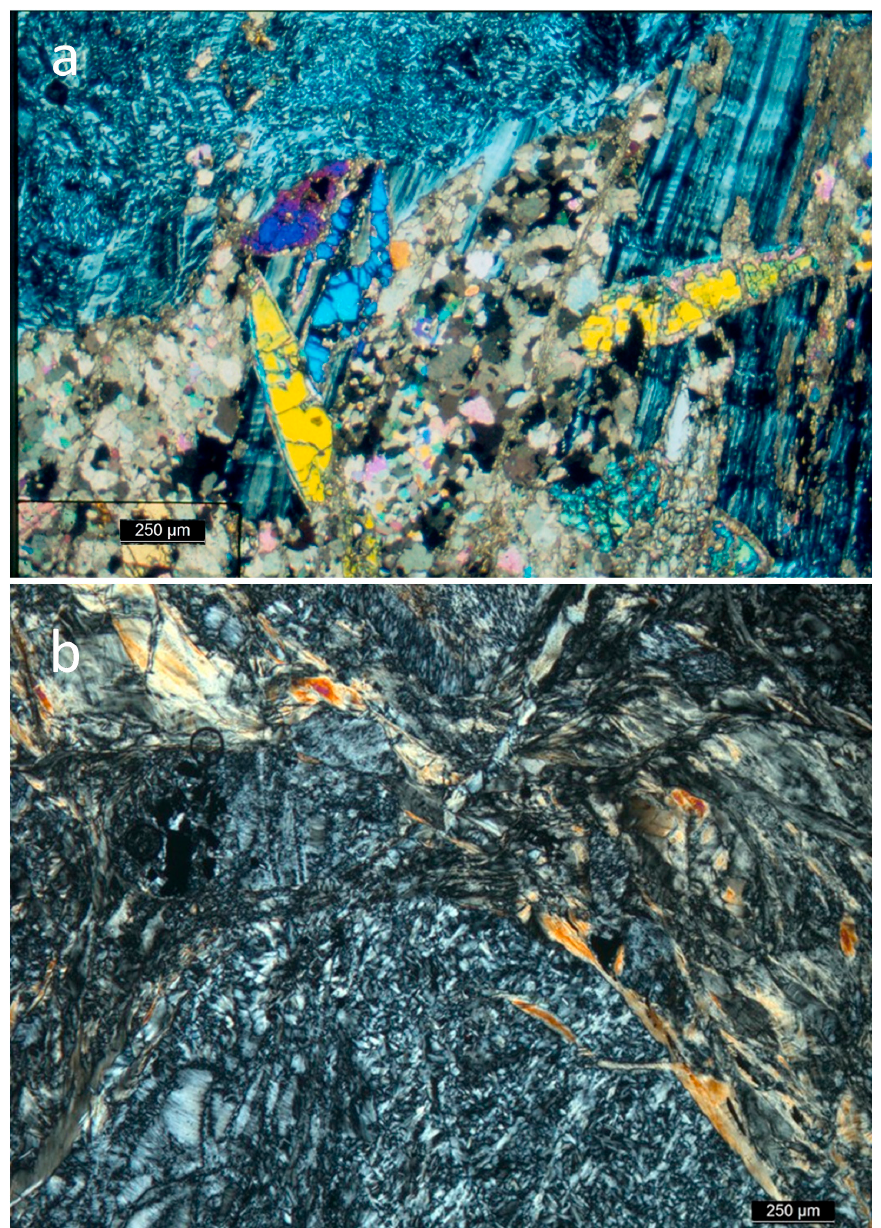
Figure 1. ( a ) Serpentinite from Macael: Most original minerals have been replaced by serpentine. The latter was replaced by carbonates in a later stage and acicular crystals of amphibole were cutting the serpentine in a final metamorphic transformation. Cross Nichols microphotograph. ( b ) Serpentinite from Cabo Ortegal (Moeche). The original ultramafic rock completely transformed into serpentine. Fibrous chrysotile could be identified by cutting the other serpentine phases of the rock. Cross Nichols